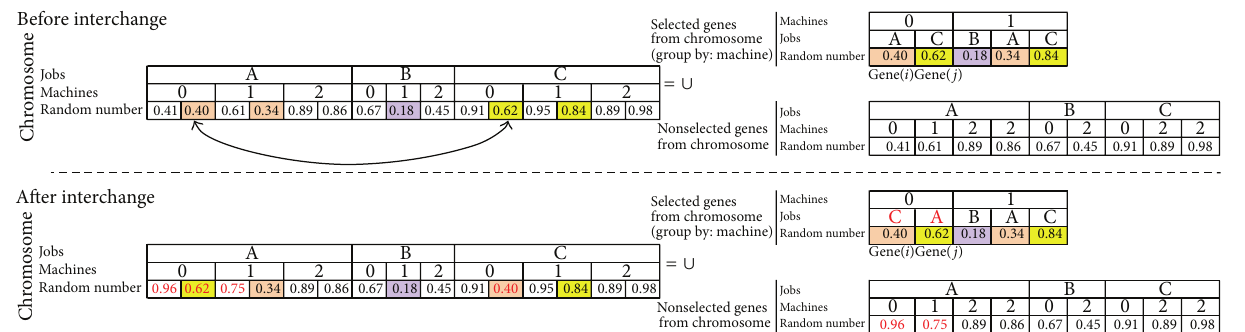
Figure 8: An example for calibration of random numbers on the chromosome for intermachine